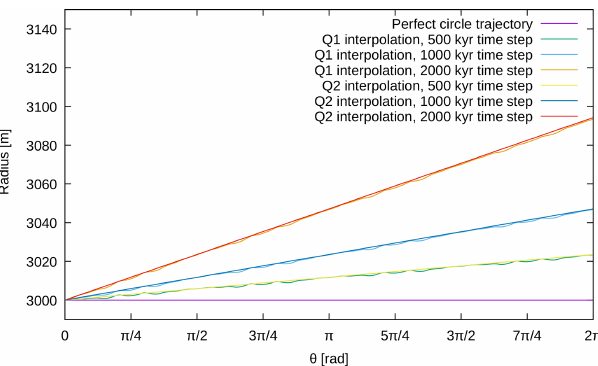
Figure C2. Results for the rotation benchmark obtained with differ- ent time steps and advection schemes.